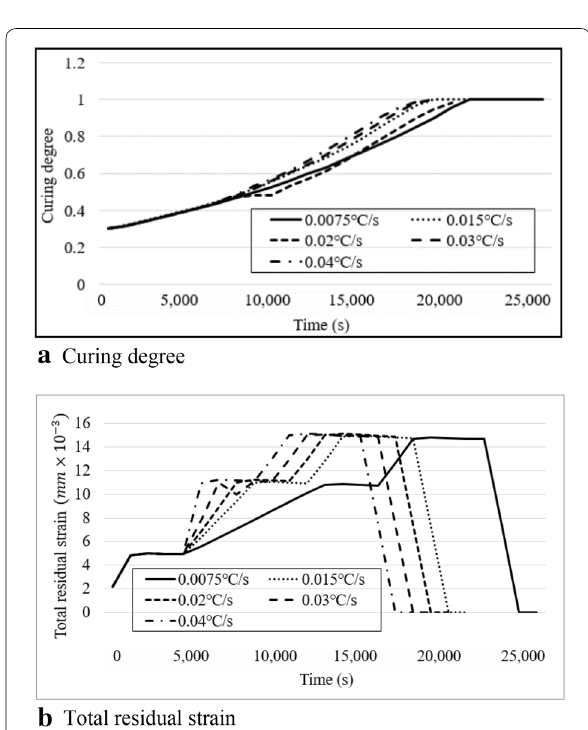
Figure 24 Results of curing analyses according to the heating rates